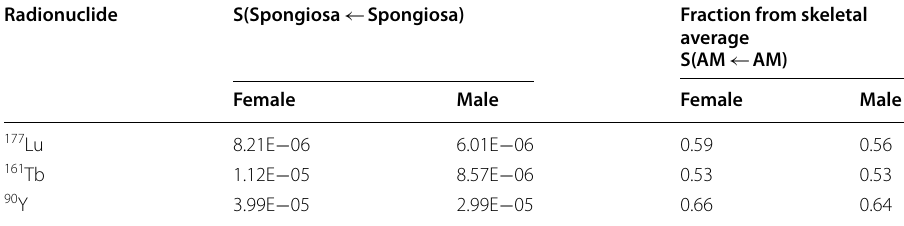
Table 4 Skeletal-averaged spongiosa S-values (mGy/MBq-s) calculated using the sources AM, IM, and TBS. The fraction from the skeletal average S(AM on the right Radionuclide S(Spongiosa